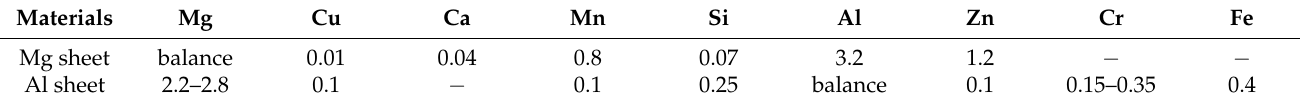
Table 1. Chemical compositions of AZ31B Mg sheet and 5052 Al sheet (wt. %).